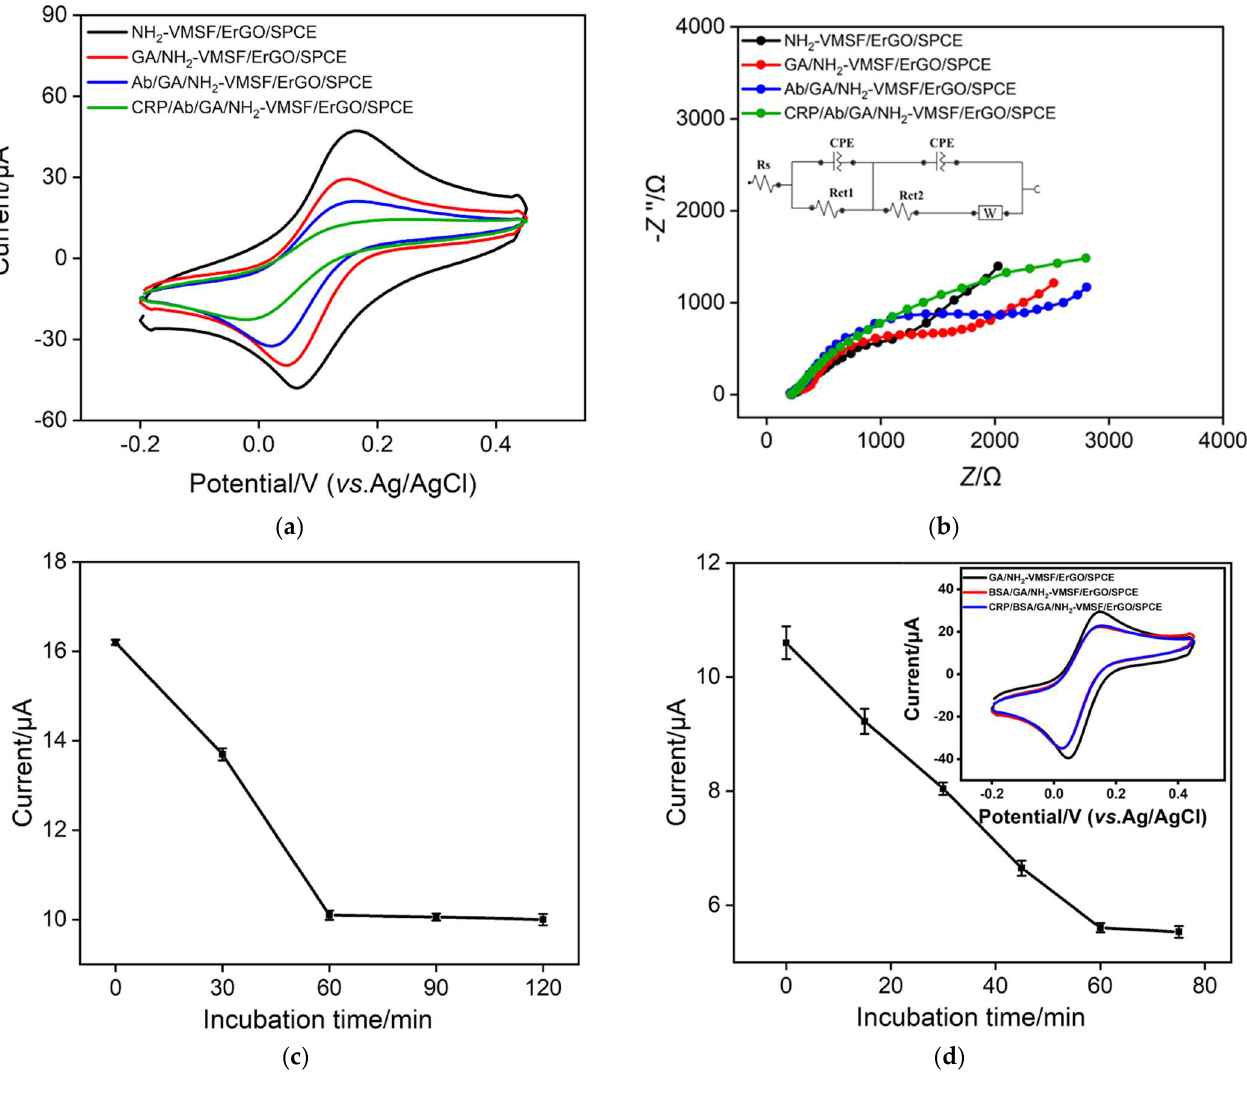
Figure 5. ( a ) CV curves obtained on different electrodes obtained in the fabrication of the immunosensor in 0.1 M KCl containing 1.25 mM Fe(CN) 63− . ( b ) EIS curves obtained on different electrodes obtained in the fabrication of the immunosensor. The electrolyte solution is 2.5 mM Fe(CN) 63−/4− containing 0.1 M KCl. Inset is the illustration for the equivalent circuit. ( c ) Effect of incubation time between Ab on the aldehyde surface on the current response of the proposed immunosensor. ( d ) Effect of incubation time between the immuno-recognitive surface and the detected CRP on the current response of the proposed immunosensor. The error bars represent the relative standard deviation (RSD) of three measurements. Inset in (d) is CV curve obtained on different electrodes. The electrolyte solution is 2.5 mM Fe(CN) 63−/4− containing 0.1 M KCl.